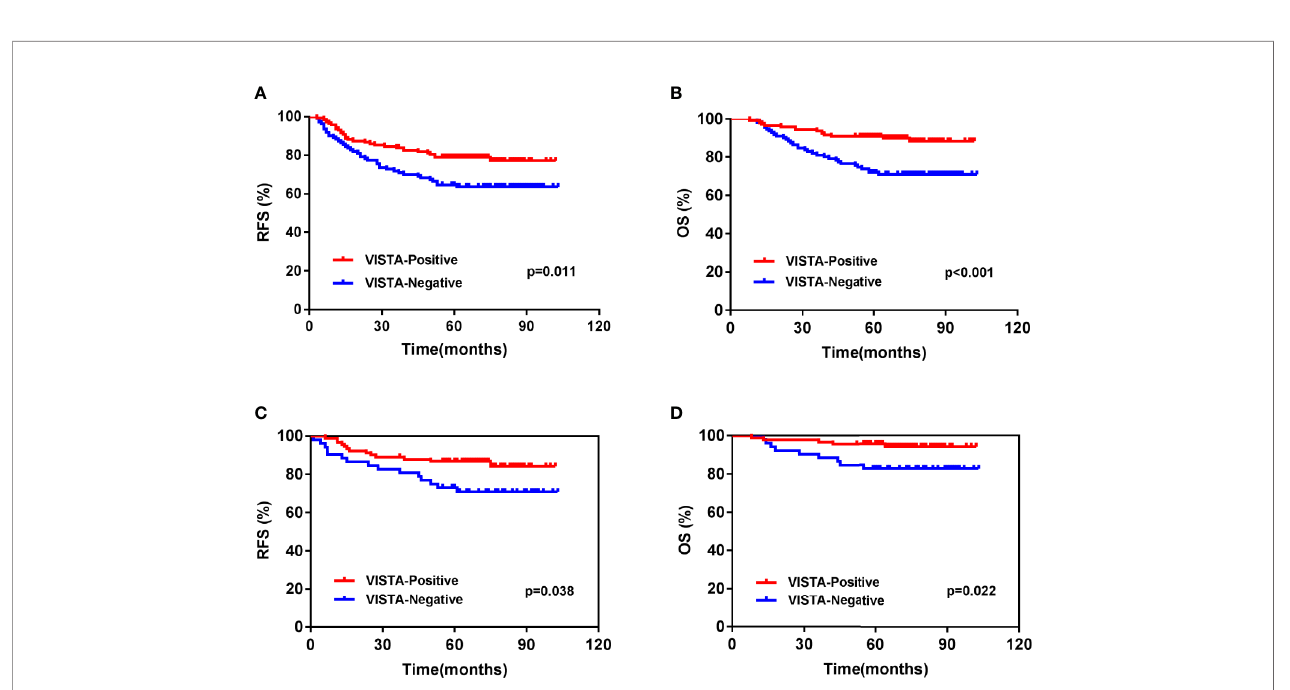
FIGURE 3 | Kaplan-Meier survival analysis of V-domain Ig suppressor of T cell activation (VISTA) expression on immune cells in triple-negative breast cancer patients. (A) Relapse-free survival (RFS) of the whole cohort. (B) Overall survival (OS) of the whole cohort. (C) RFS of T1-2N0 patients. (D) OS of T1-2N0 patients.